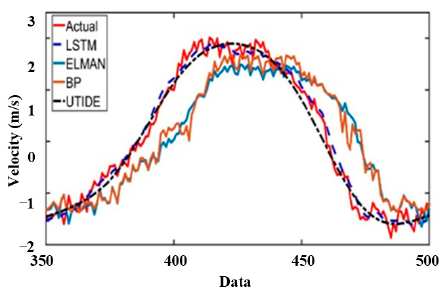
Figure 8. Comparison results of the single input prediction method by using three machine learning algorithms and UTide (20 m under sea surface). ( a ) Comparison of the back-propagation (BP) method, UTide method, and actual value, ( b ) Comparison of the ELMAN method, UTide method, and actual value, ( c ) Comparison of the LSTM method, UTide method, and actual value.